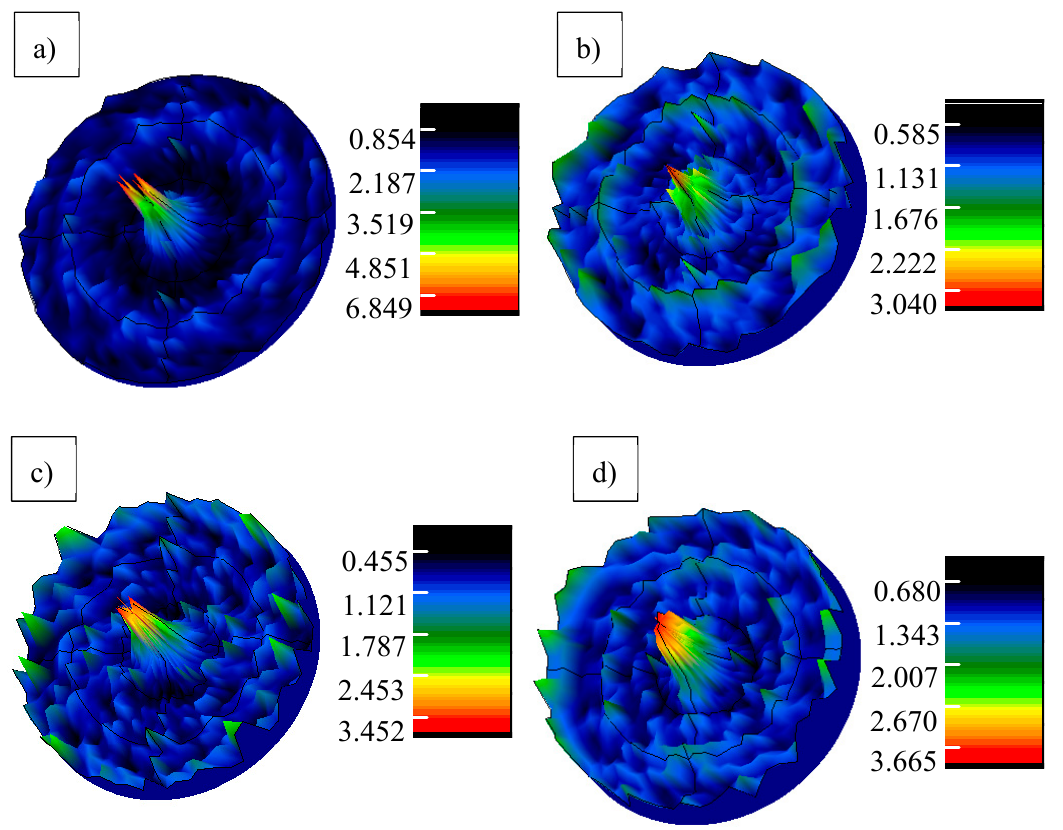
Figure 4. The {220} pole figure of the aluminium borate whiskers grown on various substrates, ( a ) The {220} pole figure of the aluminium borate whiskers grown on sapphire with (10 ⎯ 10) orientation, ( b ) The {220} pole figure of the aluminium borate whiskers grown on sapphire with (11 ⎯ 20) orientation, ( c ) The {220} pole figure of the aluminium borate whiskers grown on sapphire with (0001) orientation, ( d ) The {220} pole figure of the aluminium borate whiskers grown on sapphire with (1 ⎯ 102) orientation.